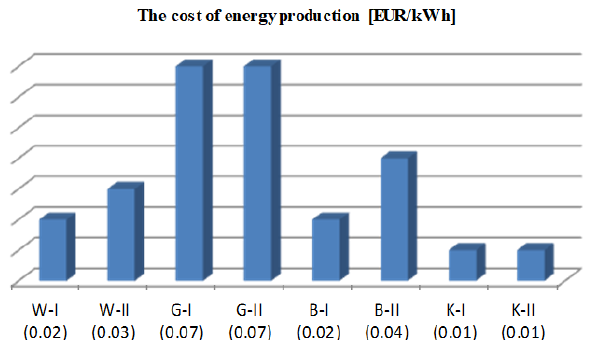
Figure 5: Production costs of 1 kWh of thermal energy Source: Own study.